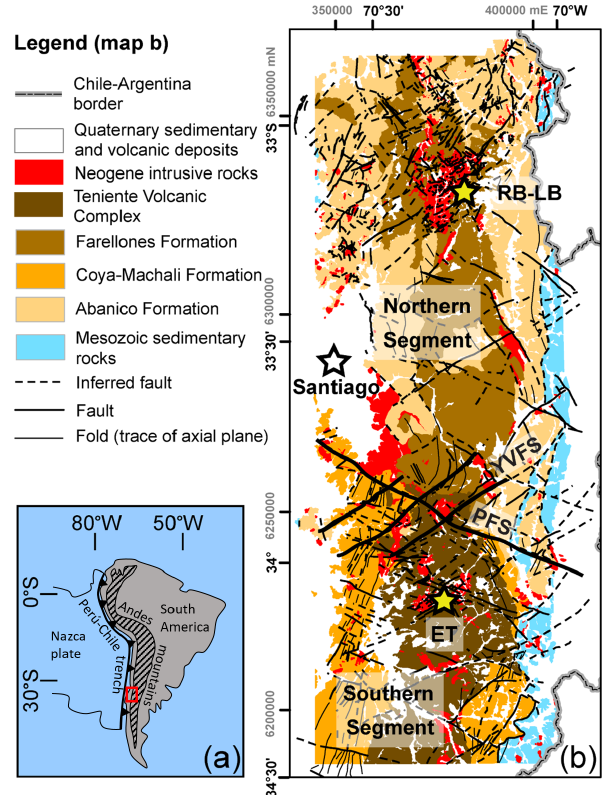
Figure 2. (a) Location of the study area (red rectangle) in South America. (b) Geology of the Andes of central Chile, based on Rivera and Falcón (2000), SERNAGEOMIN (2002), Fuentes et al. (2004), Fock (2005) and this work. Quaternary sediments and volcanic deposits not shown. PFS indicates the Piuquencillo fault system, YVFS indicates the Yeso Valley fault system, RB-LB indi- cates the Río Blanco–Los Bronces, and ET indicates El